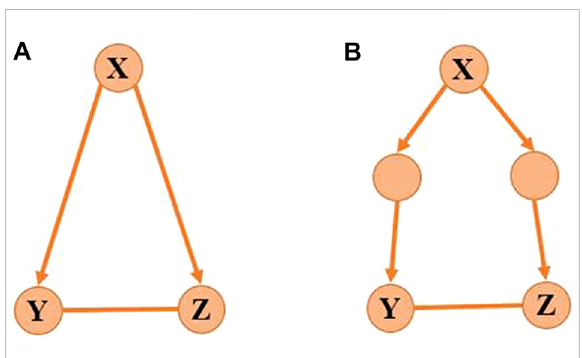
FIGURE 2 Target genes with co-regulator. (A) Genes Y and Z are direct targets of gene X , and (B) genes Y and Z are indirect targets of gene